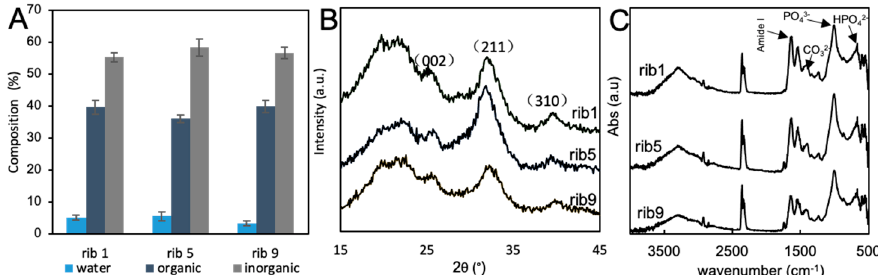
Figure 2. Chemical and crystallographical property of Carassius langsdorfii rib bone. ( A ) Composition of fish ribs. Minerals account for less than 60% of the total, and organic and water account for more than 40–45% of the total. ( B ) XRD profiles of fish ribs. The higher the rib number, the lower the crystallinity becomes. ( C ) Attenuated total reflectance Fourier transform infrared spectroscopy (ATR-FTIR) spectrum of fish ribs. The presence of carbonate in addition to phosphate was confirmed.